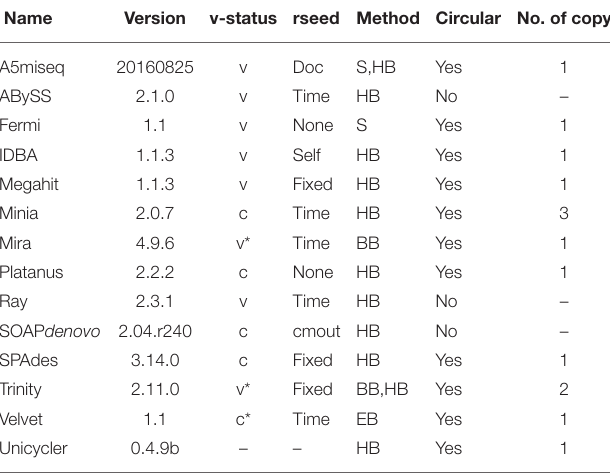
TABLE 1 | List of assembly programs and their